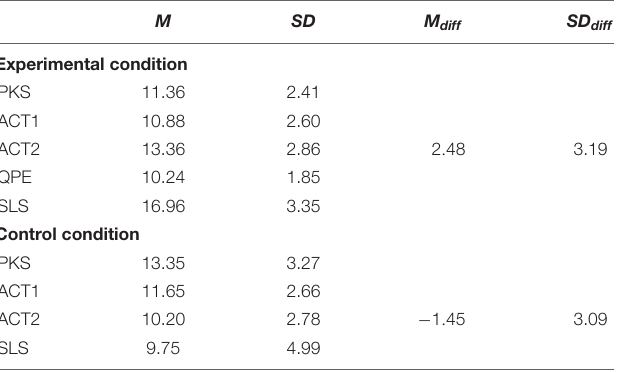
TABLE 2 | Descriptive statistics of Study 1.